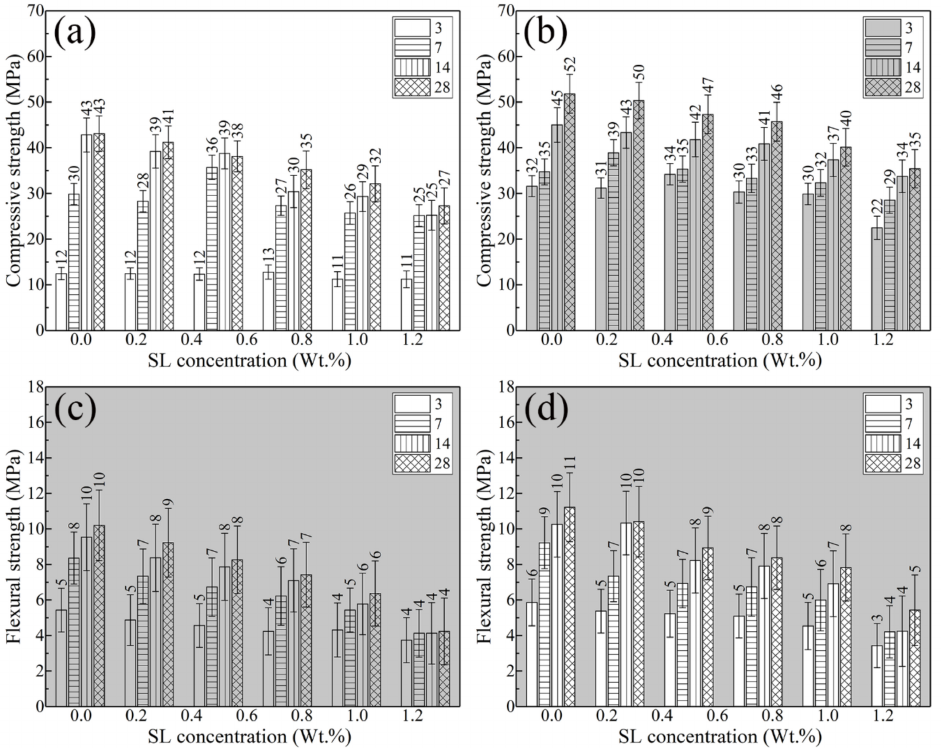
Figure 7. ( a ) E ff ect of SL concentration on the compressive strength of HCP; ( b ) e ff ect of SL concentration on the compressive strength of HCP containing 1 wt.% NS; ( c ) e ff ect of SL concentration on the flexural strength of HCP; ( d ) e ff ect of SL concentration on the flexural strength of HCP containing 1 wt.%